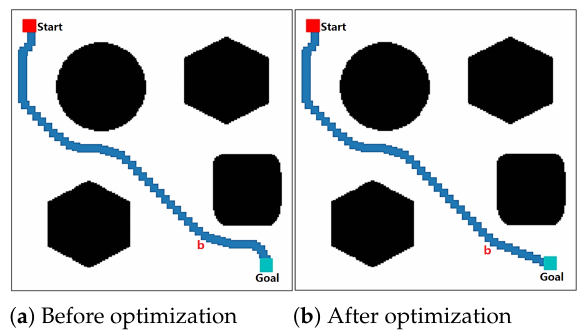
Figure 12. Path optimization on 400 × 400 map.